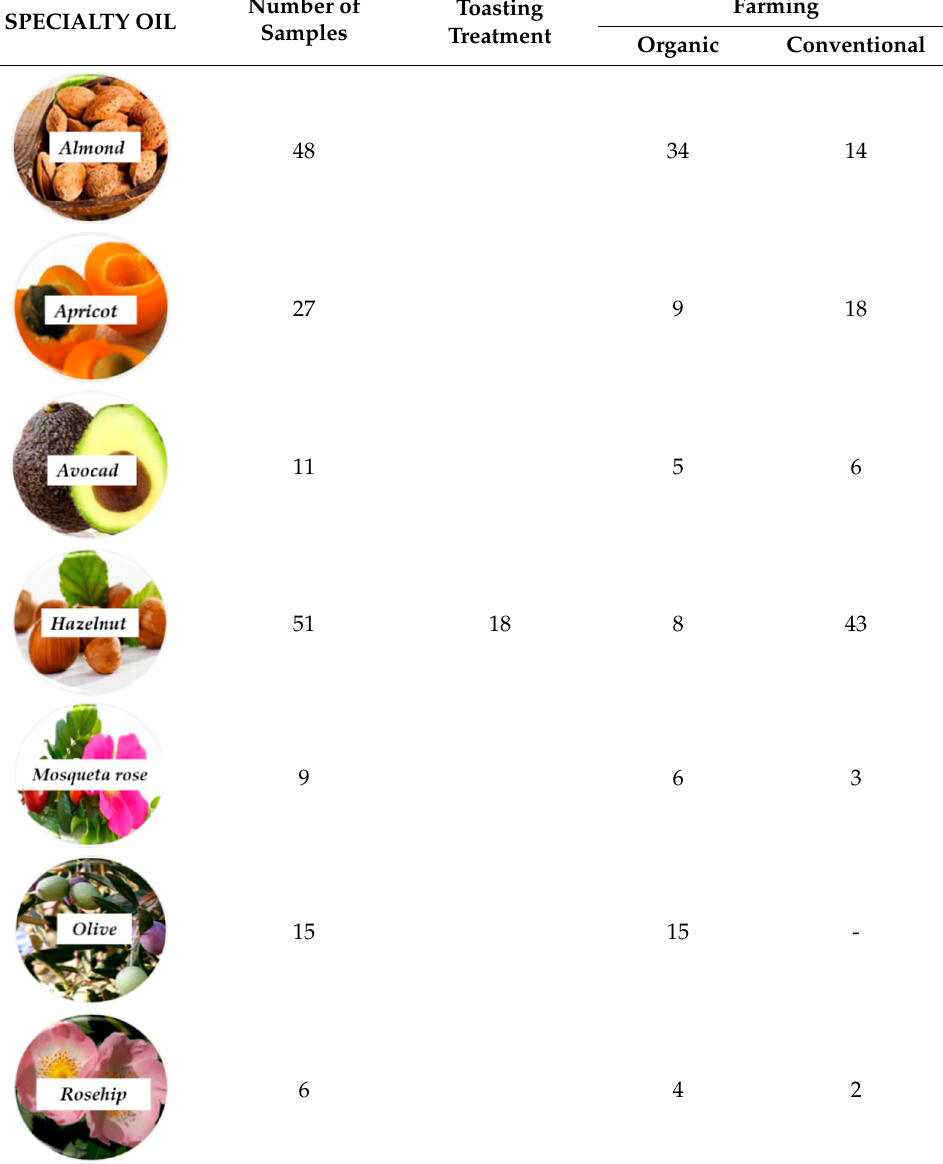
Table 1. Sample information: number of samples, type of farming, and preliminary roasting treatment undergone for specialty oils belonging to each botanical species studied.